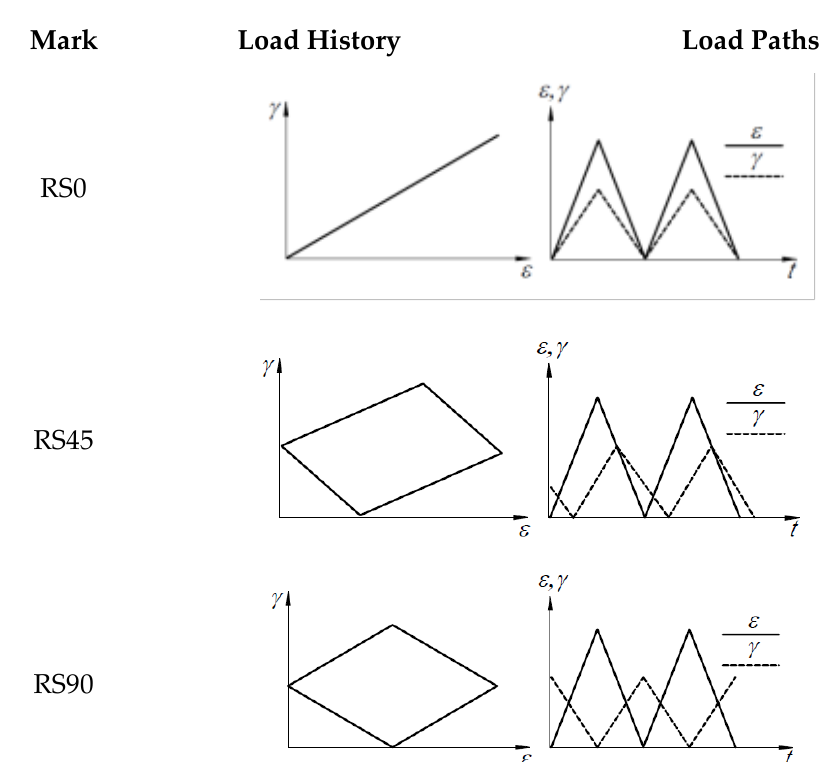
Figure 2. Evolutions of multiaxial loadings and the values of the control variable corresponding to them under the assumption of a constant quotient of maximum strains ε max = 0.003 and γ max = 0.00173 [5].